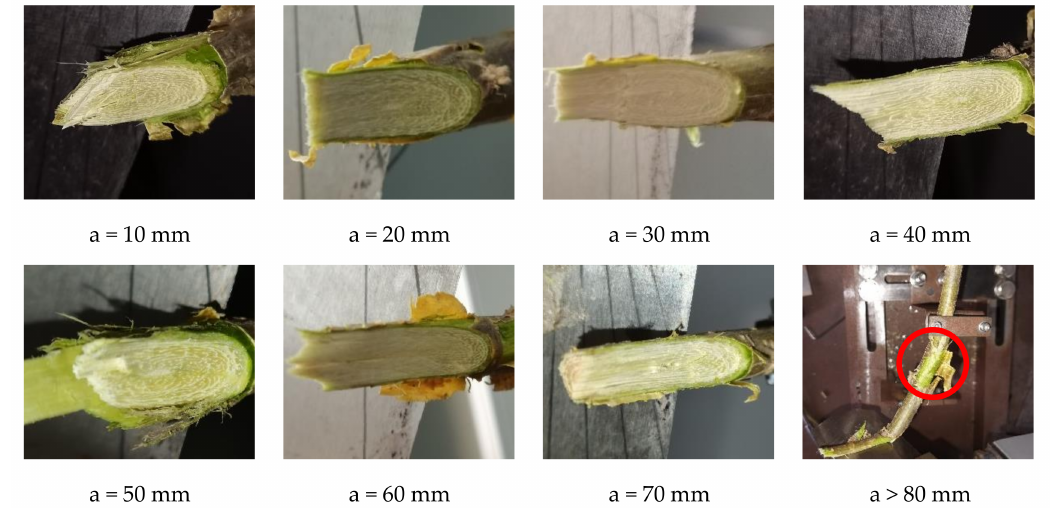
Figure 16. Cutting section with different cutting heights under unsupported